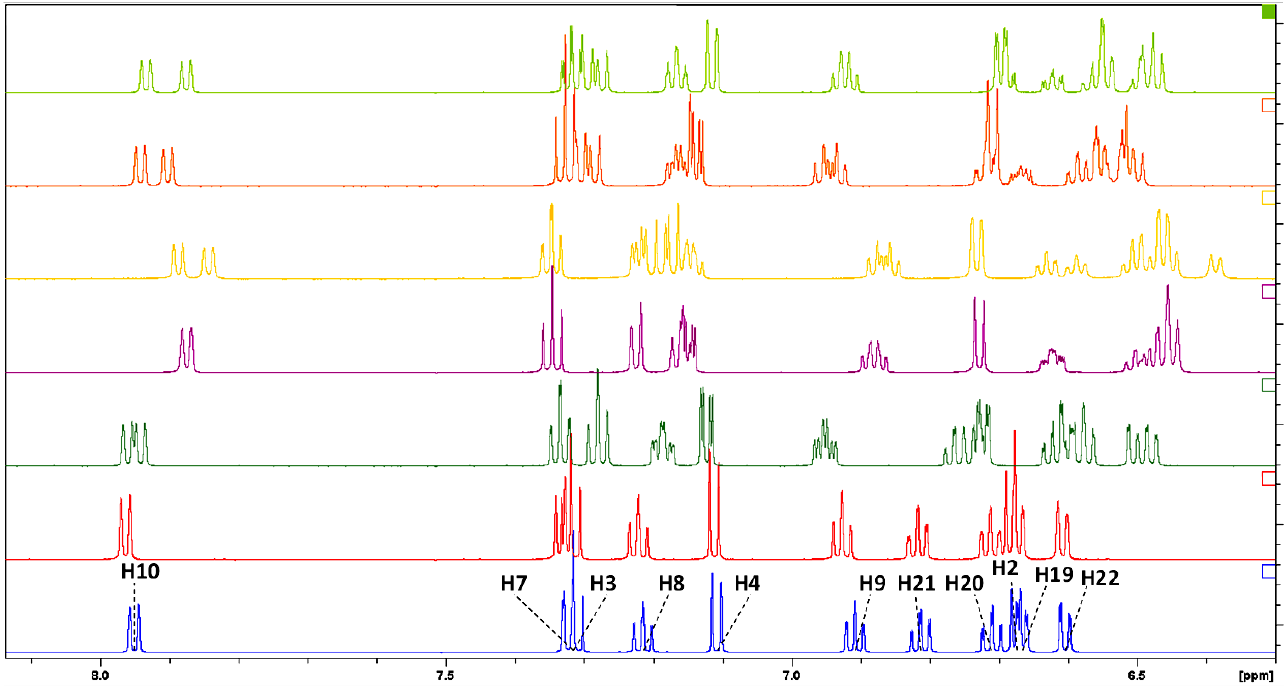
Figure 5. Partial 1 H NMR spectra (600 MHz, 298 K, 0.1 M acetate-buffered D 2 O (pH = pKa = 4.7) of the aromatic moieties of carvedilol (5 mM) in the absence of CDs ( ) or in the presence of an equimolar concentration of αCD ( ), βCD ( ), γCD ( ), HPβCD ( ), HPγCD ( ) or DIMEB ( ).